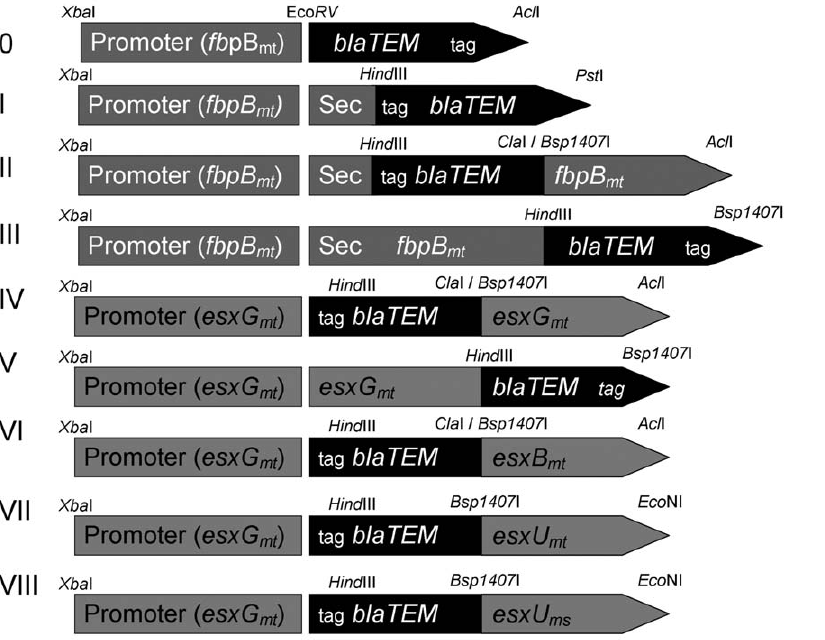
Figure 1. Schematic representation of the reporter fusion constructs. Shown are only the promoter regions, the truncated b -lactamase ( blaTEM ) and the fused ORF with restriction endonuclease sites for cloning (not drawn to scale). Additional epitope tags for anti HA antibodies are also annotated. The roman numbers on the left side correspond to the vector numbers. Along with blaTEM the vector pI-blaTEM contains the ORF encoding the 40 aa N-terminal sec-secretion signal peptide of FbpB (Rv1886c). The vector pII-blaTEM originated from pI-blaTEM and contains the additional 285 codons of the mature FbpB. In the plasmid pIII-blaTEM blaTEM is C-terminally fused to the ORF fbpB (325 codons). In pIV-blaTEM and pV-blaTEM the ORF esxG (Rv0287, 96 codons) is either C- or N-terminally fused to blaTEM . pVI-blaTEM originates from pIV-blaTEM with esxG substituted for esxB ( Rv3874 , 99 codons). In pVII-blaTEM and pVIII-blaTEM esxG is substituted for either esxU mt ( Rv3445c, 104 codons ) or esxU ms ( MSMEG_1538, 102 codons ). 0 stands for pOLYG- blaTEM expressing only the truncated version of Bla TEM-1 (267 aa) lacking the 19 aa secretion signal peptide (BlaTEM). Note that the constructs 0 and I-III are expressed by the fbpB promoter (368 bp region upstream of the start codon) whereas the esx constructs are under the control of the esxG mt promoter (500 bp region upstream of the start